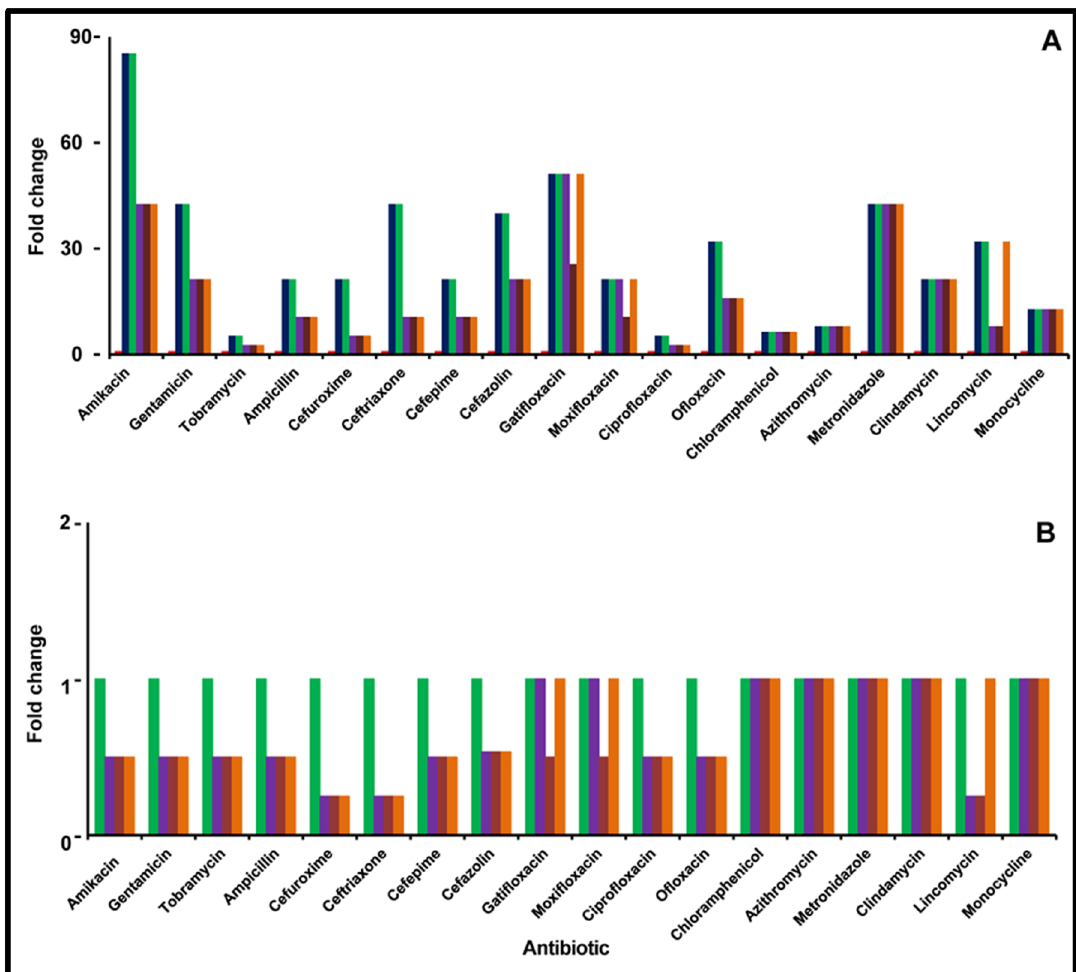
Figure 7. Fold change in minimum biofilm eradication concentration (MBEC) of the antibiotic of monomicrobial ( S. epidermidis ) and polymicrobial ( S. epidermidis plus C. albicans ) biofilms compared to planktonic cells of S. epidermidis ( A ) and comparison of MBEC between monomicrobial ( S. epidermidis ) and polymicrobial ( S. epidermidis plus C. albicans ) biofilms ( B ). The effect of the antimicrobial agent was evaluated by the XTT method as described. The coloured bars indicate the following: red square , S. epidermidis in the planktonic phase (24 h); blue square, S. epidermidis in the biofilm phase (24 h); green square, S. epidermidis in the biofilm phase (48 h); purple square, S. epidermidis and C. albicans simultaneously incubated to form biofilm (24 h); brown square, C. albicans biofilm preformed for 24 h and then S. epidermidis planktonic cells were added; orange square, S. epidermidis biofilm preformed for 24 h and then C. albicans planktonic cells were added. Experiments were performed in